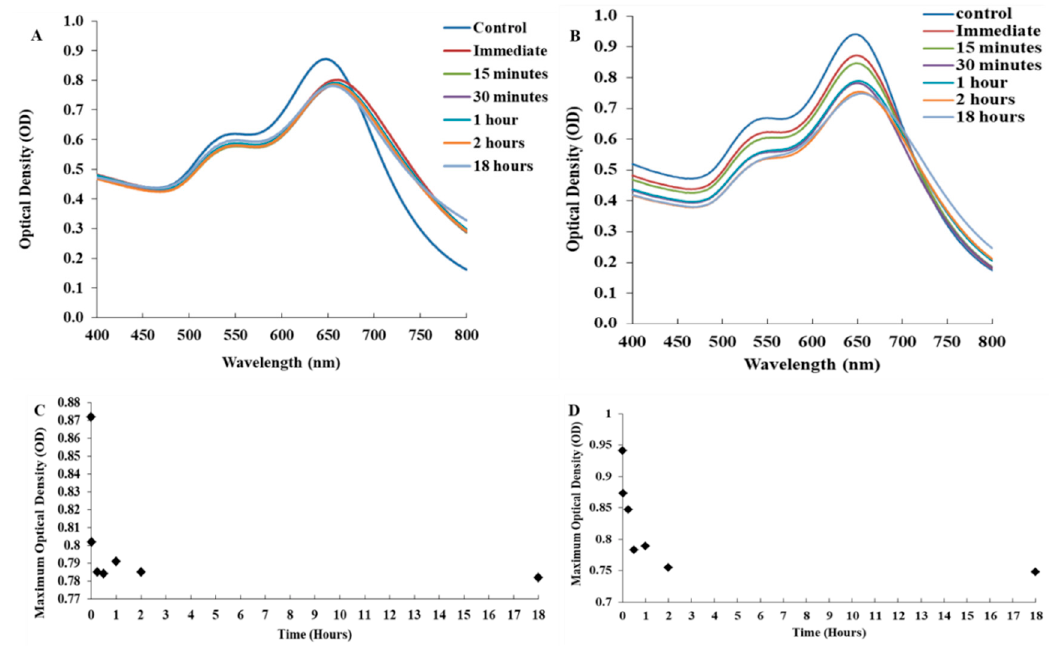
Figure 4. Stability of the FAO-AuNs in serum ( A , C ) and salt ( B , D ).